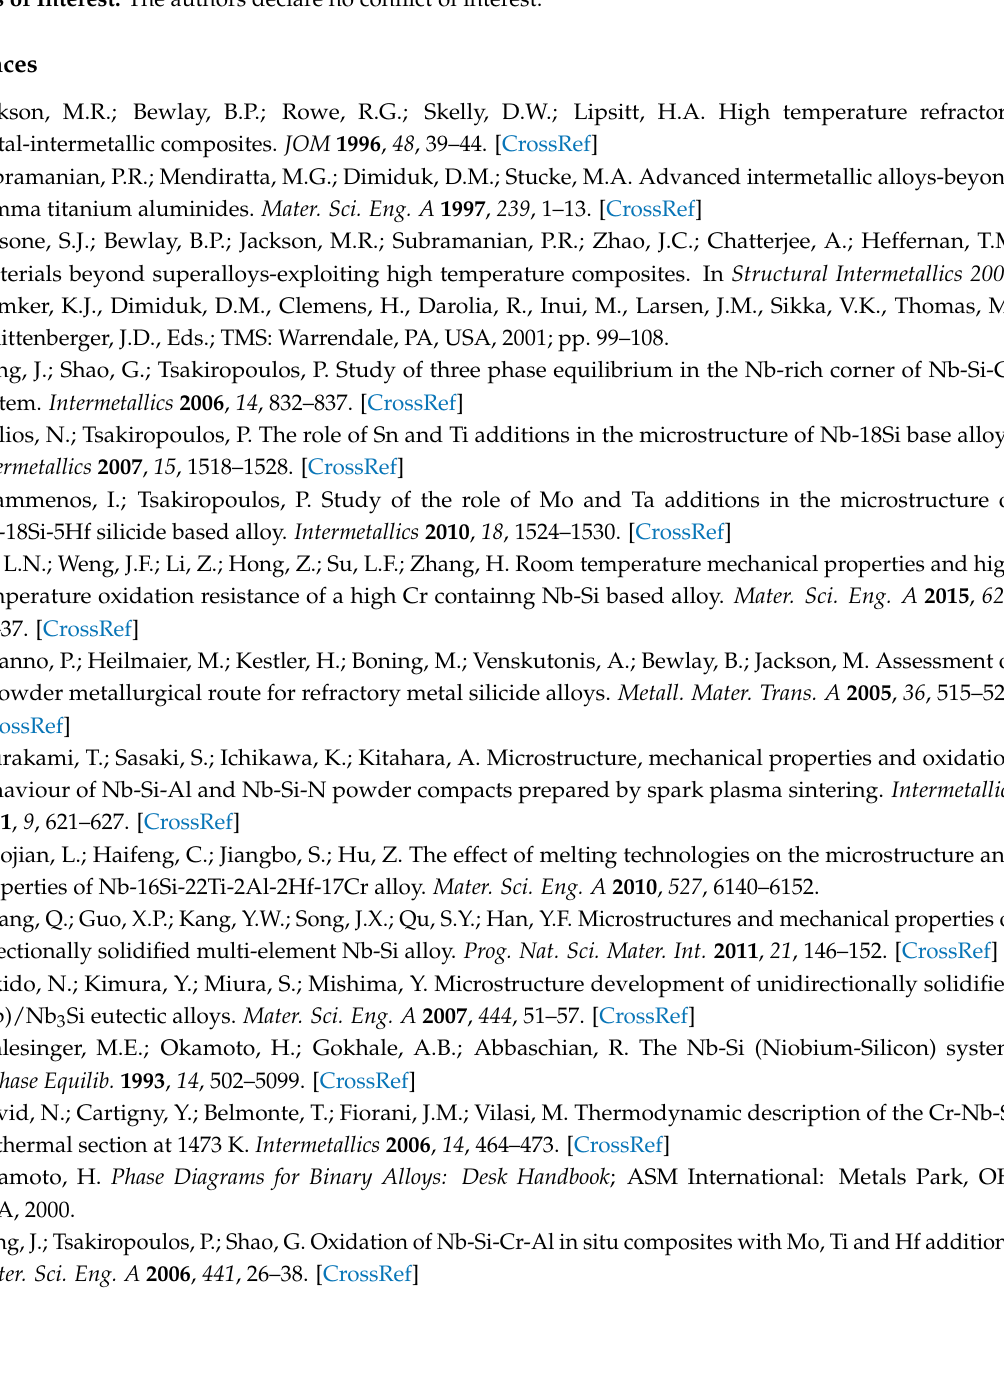
Figure S1: X-ray diffractograms of cast and heat treated CM1-10g and CM1-600g, Figure S2: X-ray diffractograms of cast and heat treated CM1-6mm and CM1-8 mm bars, Figure S3: X-ray diffractograms of cast CM1-OFZ grown at growth rates of 12, 60 and 150 mm/h, Figure S4: Relationships between W and Ti concentrations in the Nbss (a) in as-cast CM1-10g and (b) CM1-OFZ where data for all three growth rates is included, Figure S5: Backscattered electron image of a silicide in as-cast CM1-OFZ grown at 150 mm/hr and X-ray maps of the elements in the alloy, Figure S6: X ray diffractograms of heat treated CM1-OFZ grown at 12, 60 and 150 mm/h, Table S1: Summary of microstructures in arc melted, suction cast and OFZ alloy